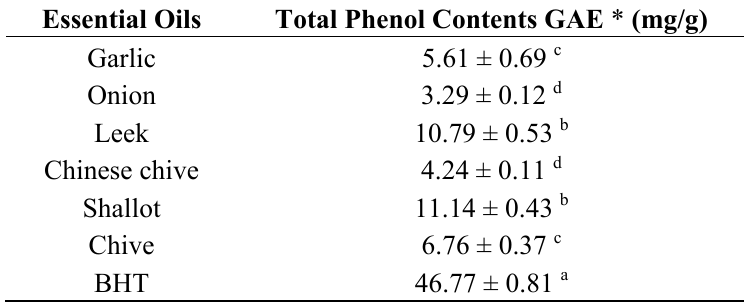
Table 3. Total Phenol contents (TPCs) of garlic, onion, leek, Chinese chive, shallot, chive EO and